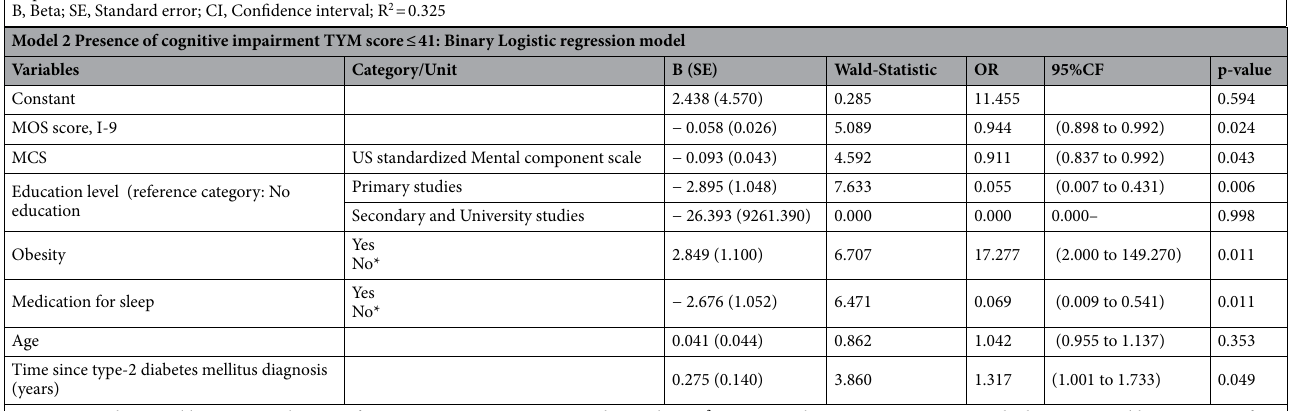
N = 64; Dependent variable: Presence/Absence* of Cognitive impairment. Homer and Lemeshow: X 2 = 4.158; p-value = 0.843. B, Beta; SE, Standard error; OR, Odd Ratio; CI, Confi- dence interval. Variables included in the initial models: Gender, Age, Education level, Employment status, Time since type-2 diabetes mellitus diagnosis, HbA1c, Medication for cognition, Medica- tion for sleep, Medication for pain, Insulin therapy, History of anxiety, History of depression, Physical comorbidity, Complications, Diabetic retinopathy, Diabetic nephropathy, Diabetic foot, Cardiovascular disease, Obesity, AHT, Dyslipidaemia, Pain duration, Pain intensity, HADS Anxiety, HADS Depression, MOS score, I-9, PCS and Table 4. Factors related to cognitive function (Test Your Memory) in DNP patients. Multivariate analysis.